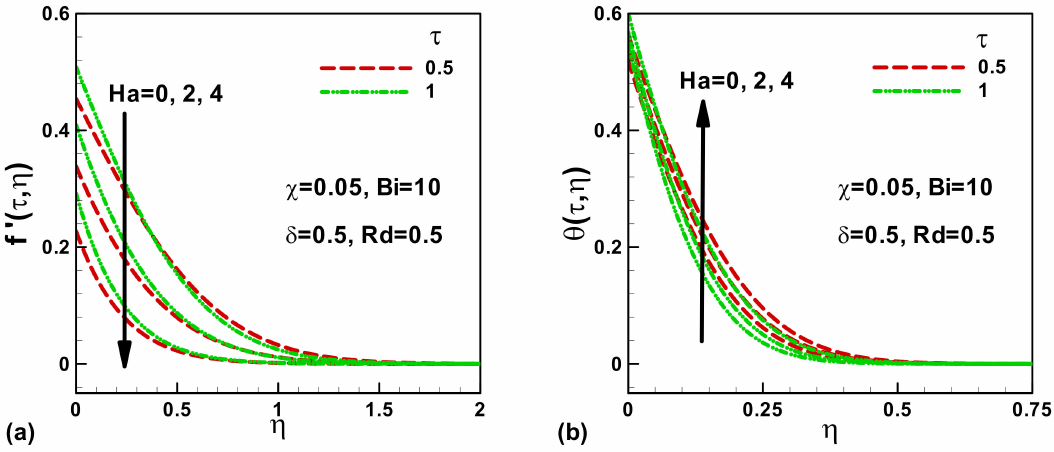
Figure 1. E ff ects of magnetic field Ha and dimensionless time τ on ( a ) dimensionless velocity, and ( b ) dimensionless